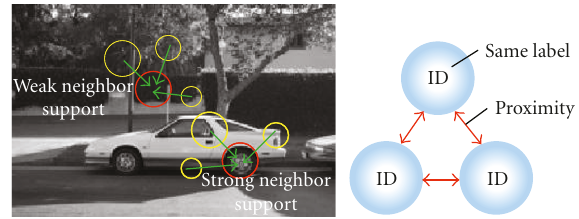
Figure 5: Similarity and proximity of part-part context.